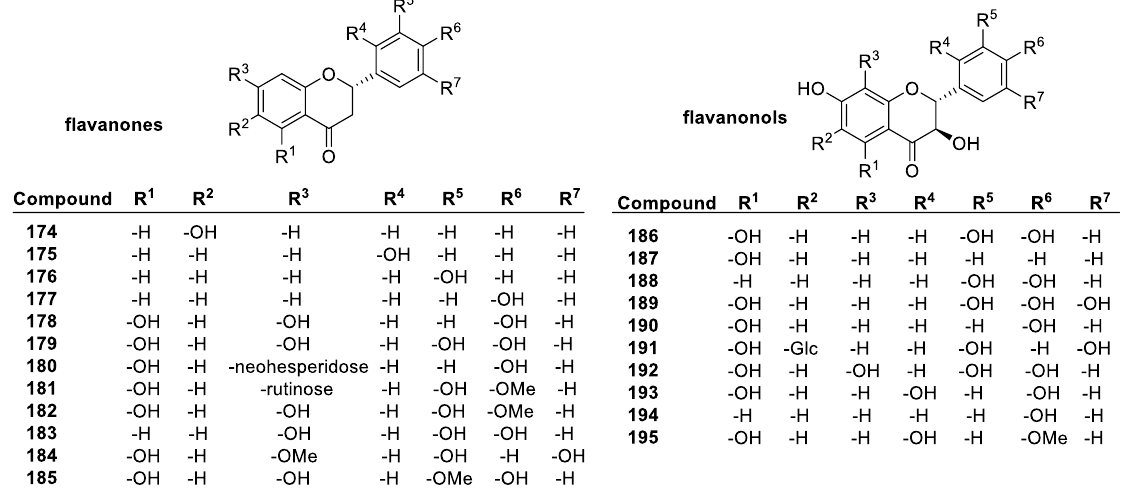
Figure 12. Representative examples of flavanones and flavanonols with antioxidant effect.